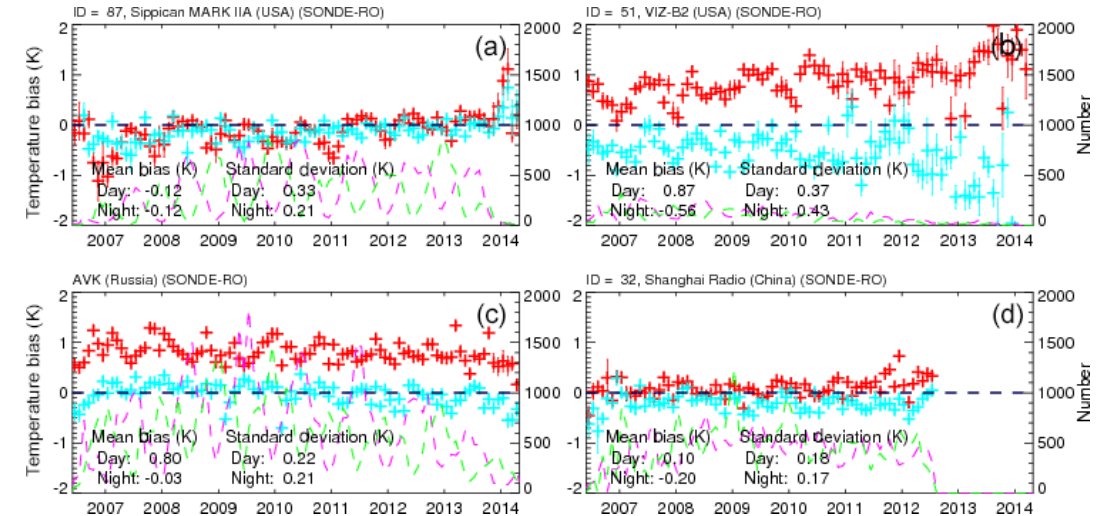
Figure 11. The time series of temperature difference at 50hPa for (a) Sippican over United States minus RO, (b) VIZ-B2 over United States minus RO, (c) Russian sonde minus RO, and (d) Shanghai minus RO in the northern hemispheric midlatitude (60–20 ◦ N).